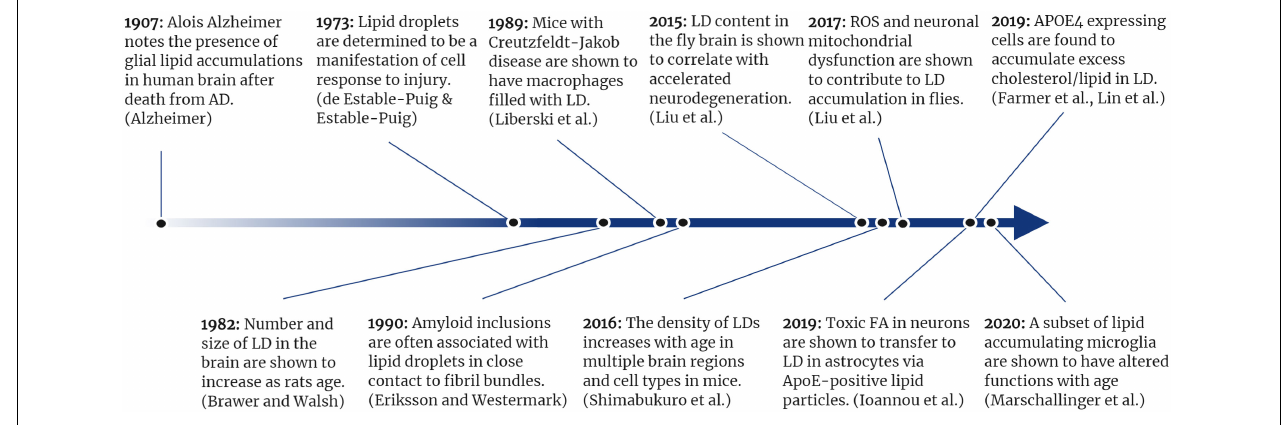
FIGURE 2 | A timeline of selected lipid droplet discoveries as they relate to neurodegenerative